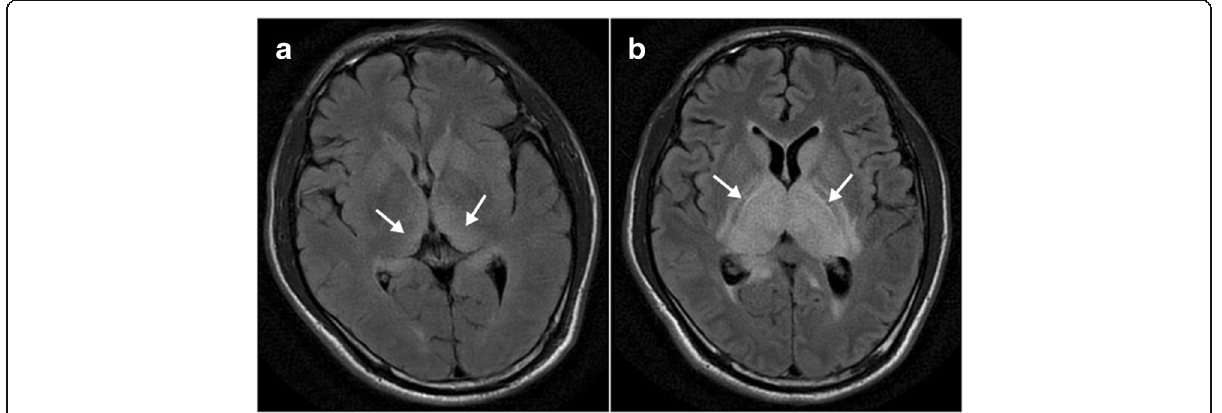
Fig. 1 Characteristic changes on MRI with FLAIR sequence on day 1 ( a ) and day 5 ( b ) of JEV patients